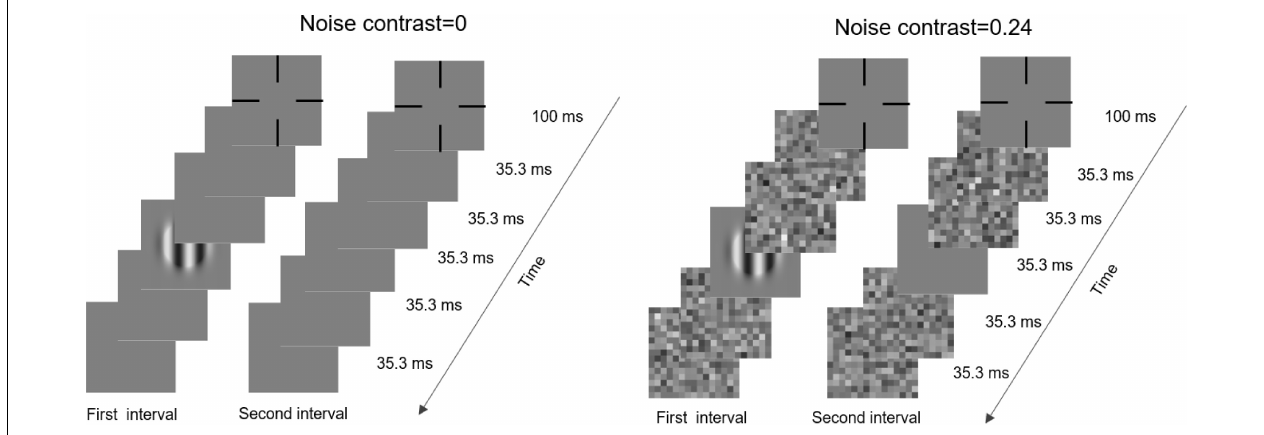
FIGURE 1 | Illustration of a typical trial in zero-noise (left) and noisy (right) conditions.